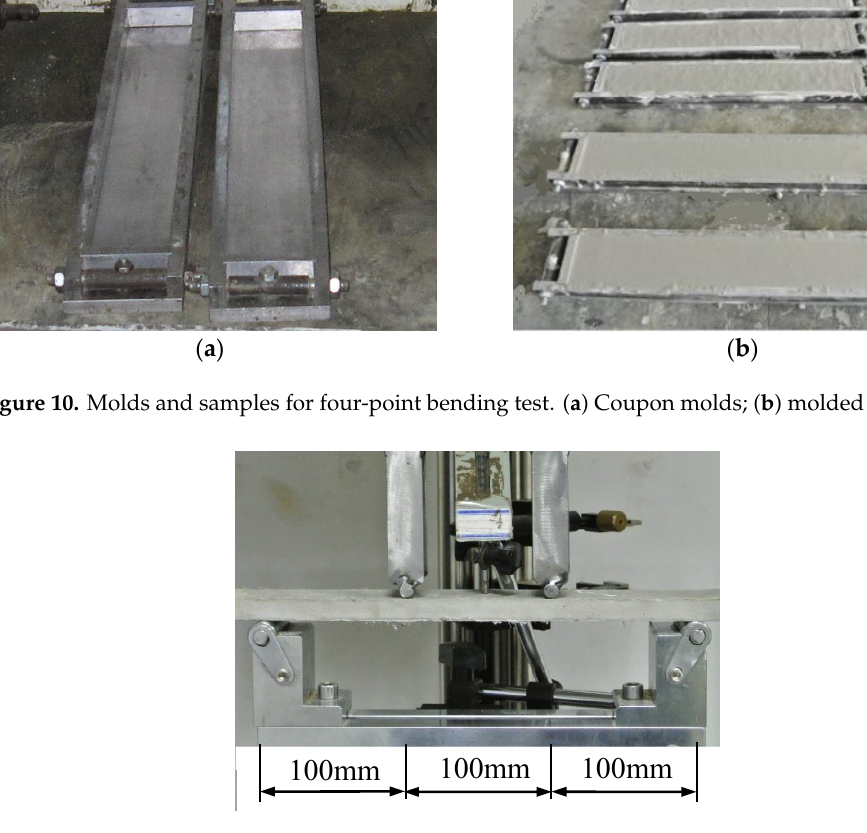
Figure 11. Setup (bending test system, Xinsansi, Shenzhen, China) of four-point bending test.